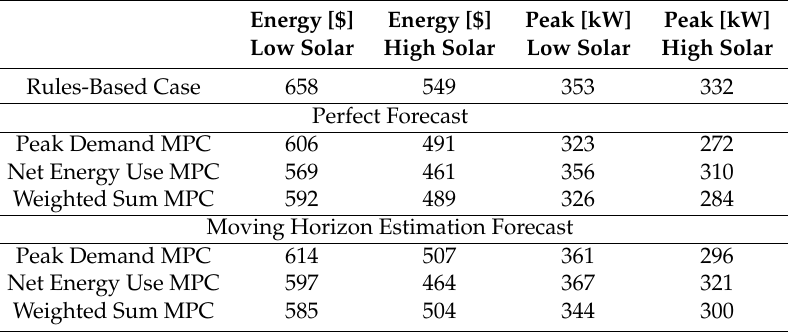
Table 1. Comparisons between the rules-based control and MPC schemes in terms of energy cost and peak load for a single day simulation, under low and high solar availabilities, and for perfect and imperfect forecasting conditions. Energy [$] Energy [$] Peak [kW] Peak